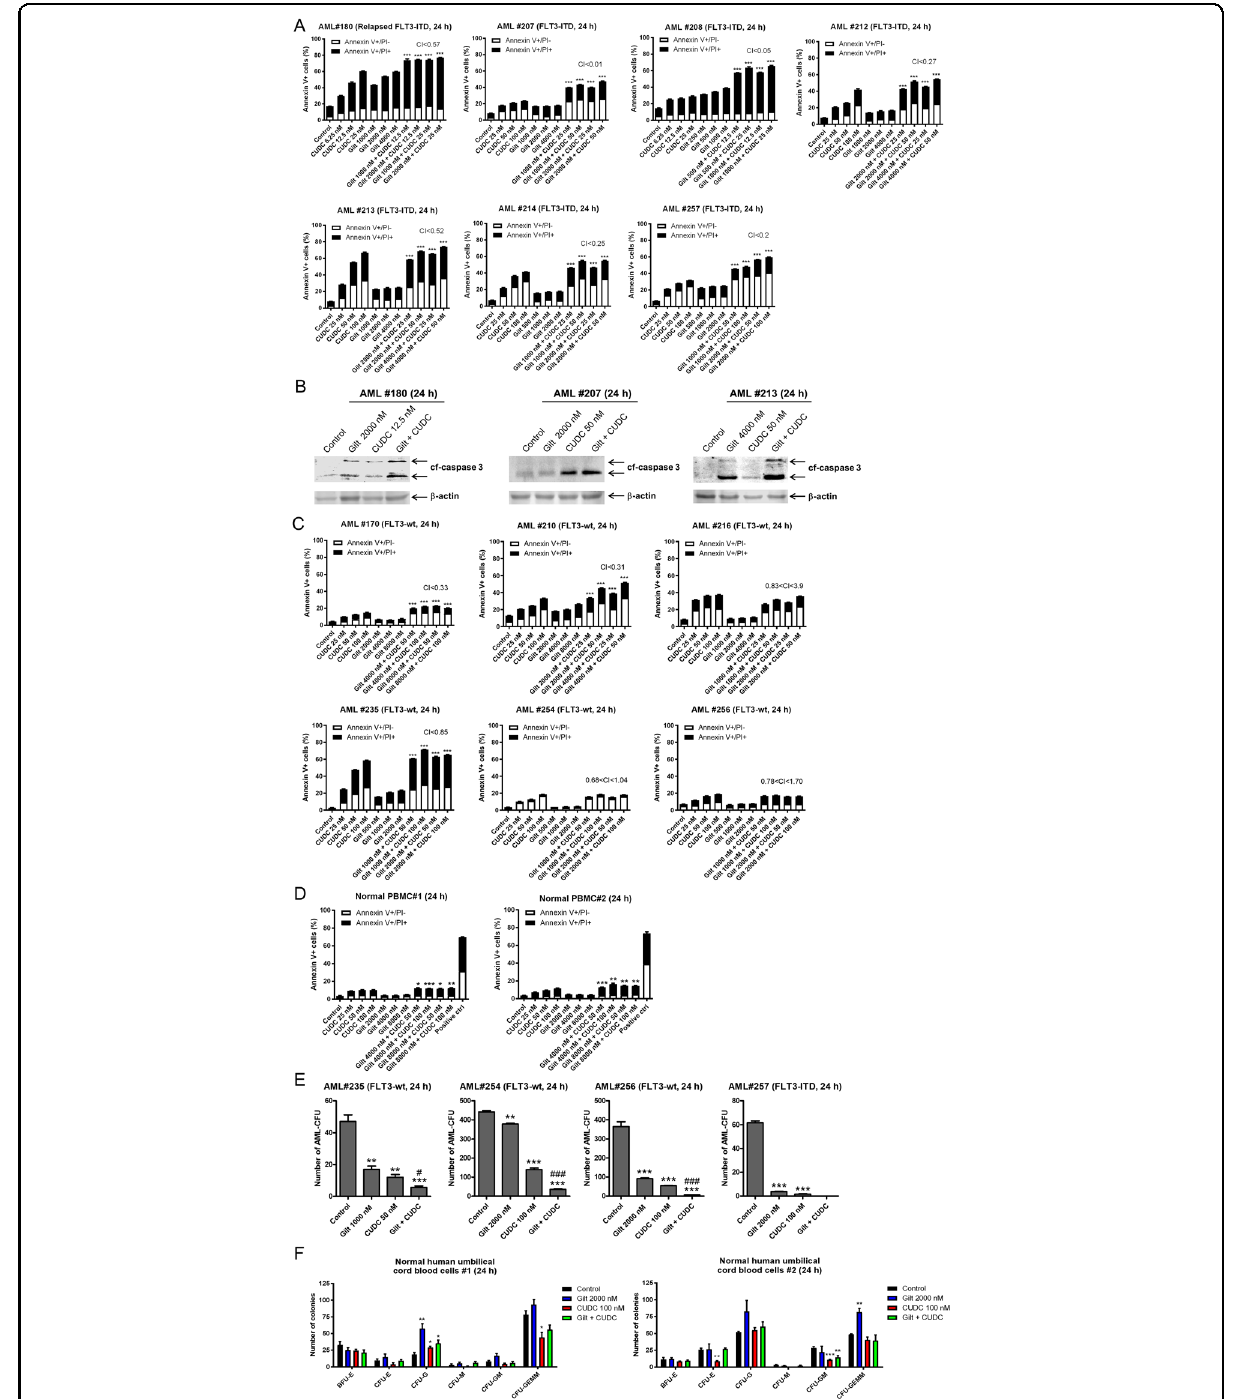
Fig. 3 (See legend on next